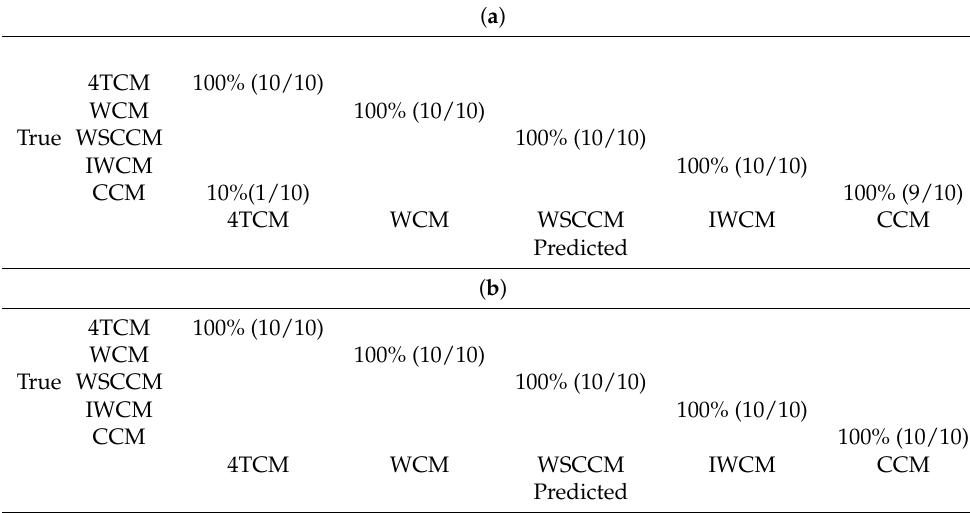
Table 11. ( a ). Confusion matrix for test using 50 graphs, where the GCN model was trained using 100 graphs. ( b ). Confusion matrix after a “multistage augmentation”: the confusion matrix shows a 100% classification